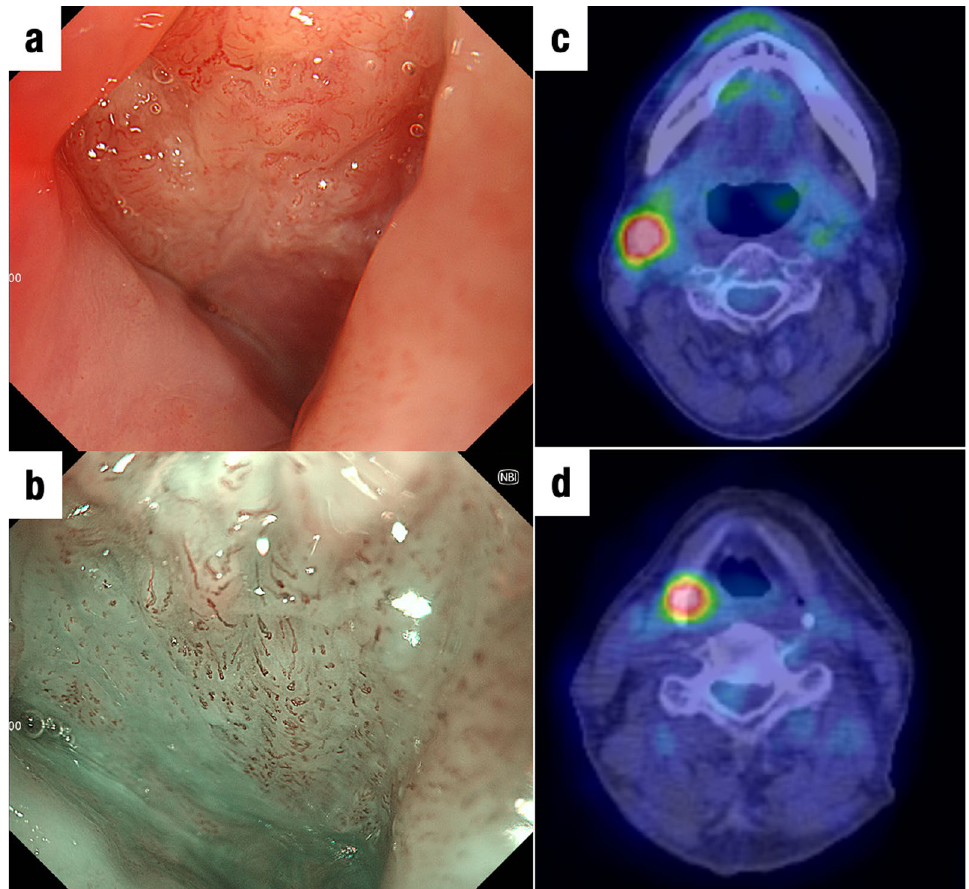
Fig. 1 Preoperative examination. a Upper gastrointestinal endoscopy showing a ridge on the right piriform fossa. b Image-enhanced endoscopy showing an irregular granular surface and microvessel pattern in the right piriform fossa. c Fluorodeoxyglucose (FDG) positron emission tomography (PET) showing high FDG uptake in the right cervical lymph node. d FDG-PET showing high FDG uptake in the right piriform